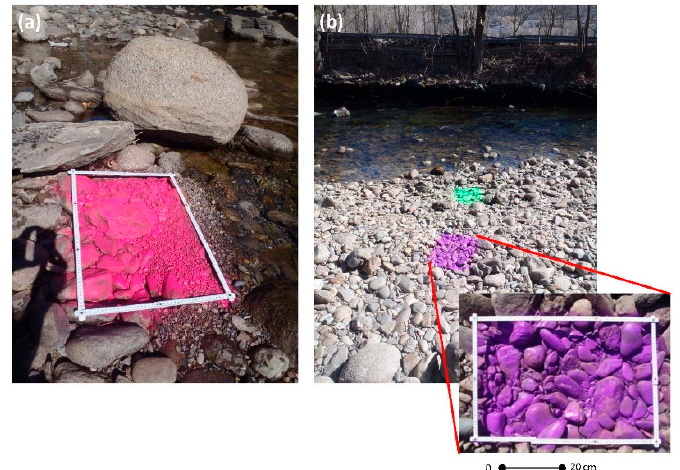
Figure 4. Painted tracers to monitor bed-material mobility. Examples are for river reaches ( a ) R2 and ( b ) R3.